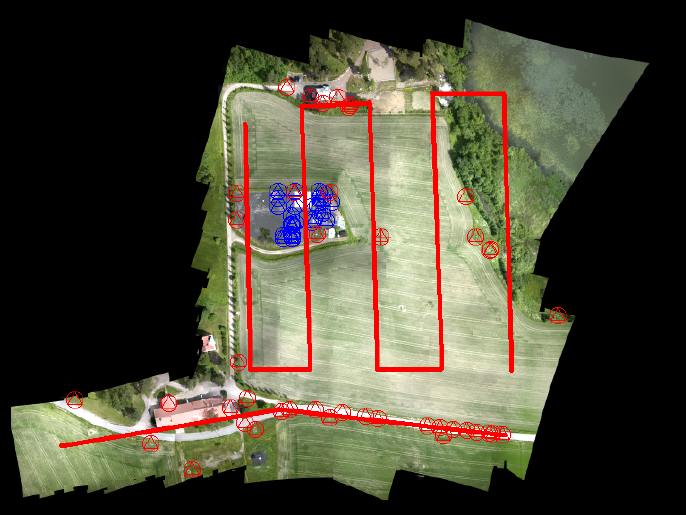
Figure 2. Flight routes of the reduced image block that was used in the SOCET SET processing. GCPs are in red and checkpoints are in